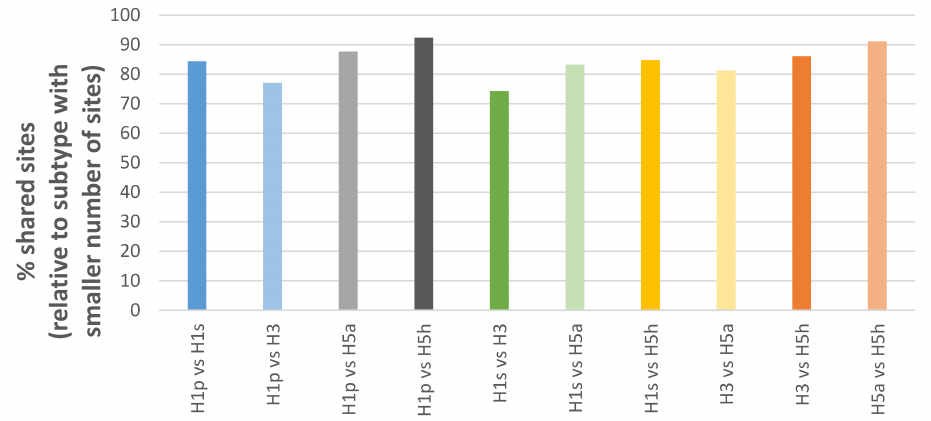
Figure 1. Overlap of passage bias sites between di ff erent influenza subtypes.